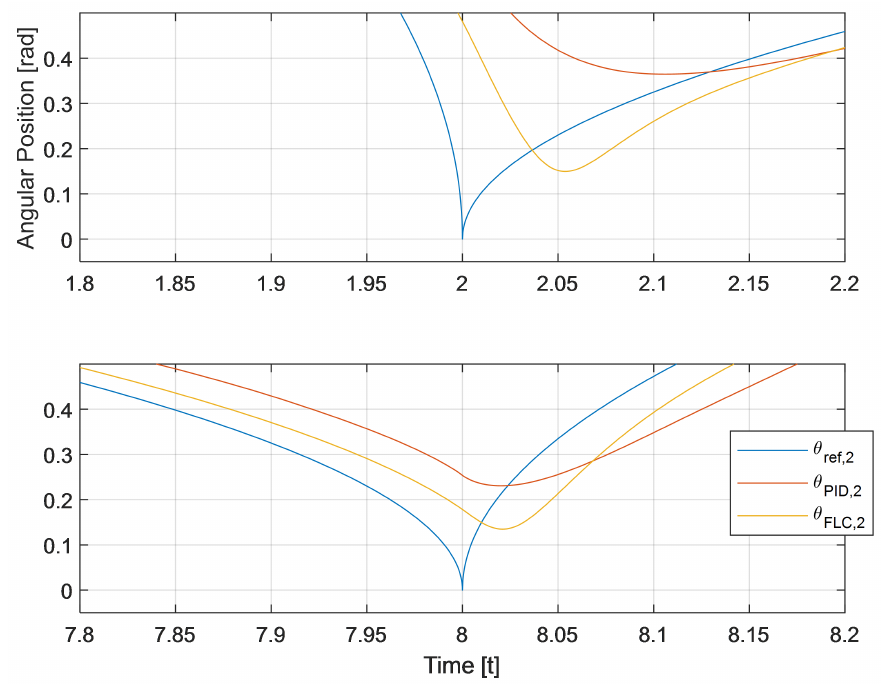
Figure 8. Zoom in a “cuspide” point